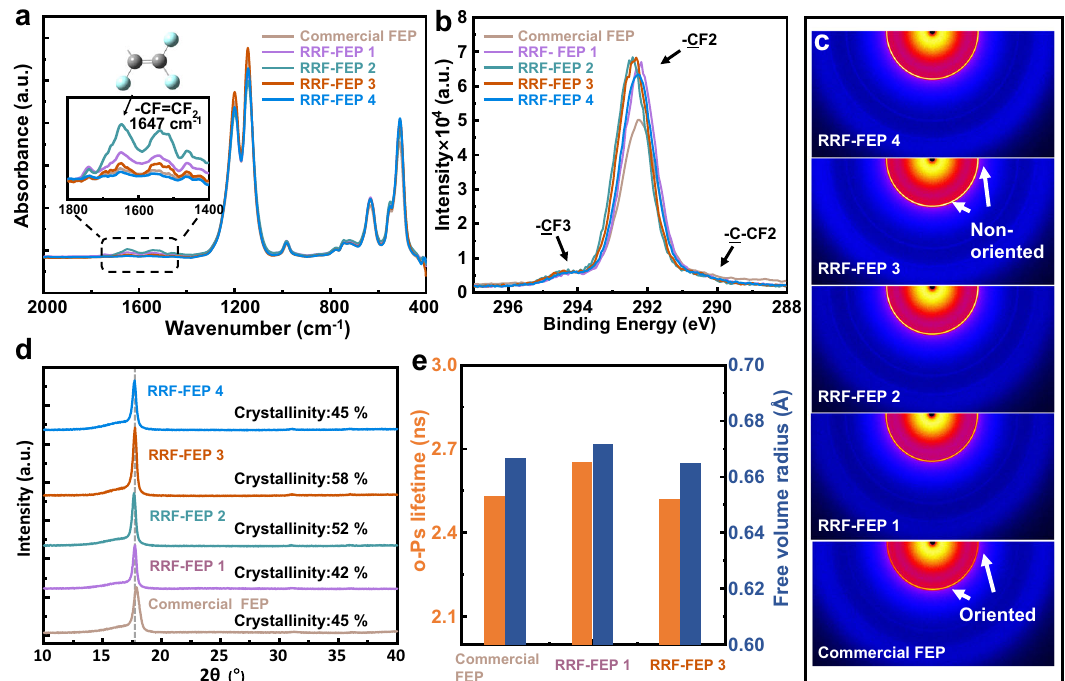
Fig. 4 Characterization of FEP fi lms. a The molecular structure diagrams of several FEP fi lms structures are given by a Fourier transform infrared (ATR- FTIR) spectrum. b C 1 s XPS spectra of FEP fi lms. c 2D-WAXD patterns of FEP fi lms. d X-ray diffraction (XRD) pattern of FEP fi lms. e The o-Ps lifetime